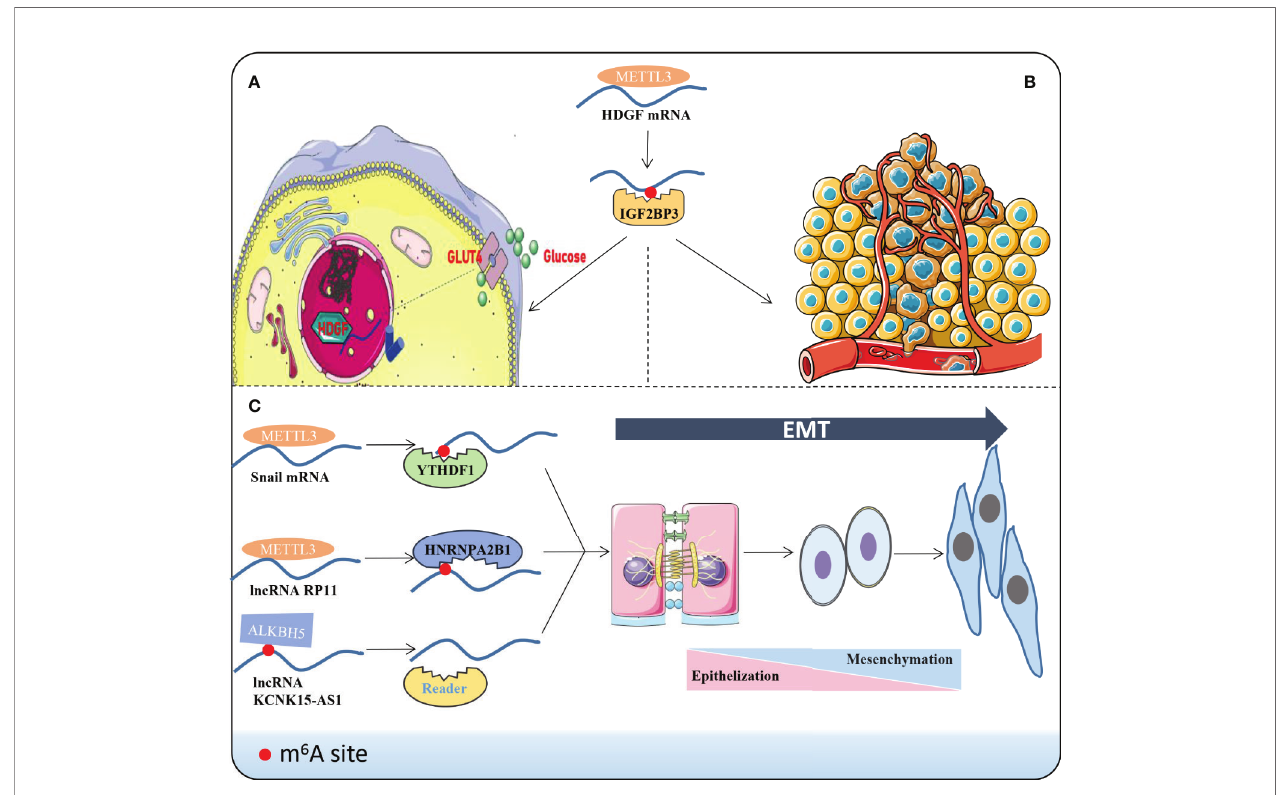
FIGURE 2 | Phenotypic changes induced by m 6 A methylation. For instance, m 6 A reader IGF2BP3 combines the m 6 A sites to improve the stability of HDGF mRNA via METTL3 manner. Subsequently, HDGF accelerates the metabolism and glycolysis (A) of gastric cancer cells and promotes angiogenesis (B) . (C) LncRNAs or mRNAs bind to the corresponding “ readers ” and drive the EMT progression through the m 6 A